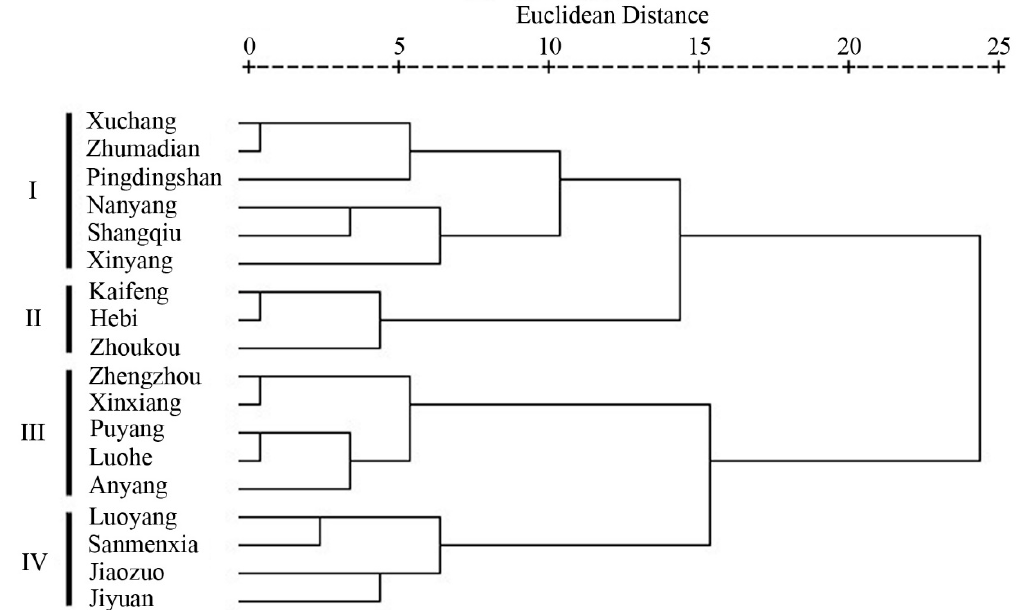
Figure 7. Dendrogram based on the Z-scored air quality index on non-attainment days (NAQI) and non-attainment days of 18 cities in 2015–2016.